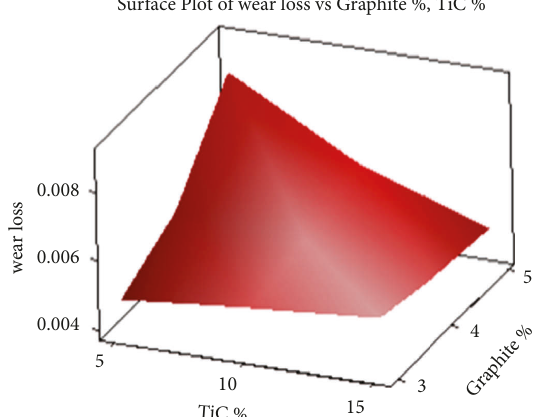
Figure 4: Surface plot graph for TiC % VS graphite % to wear loss.